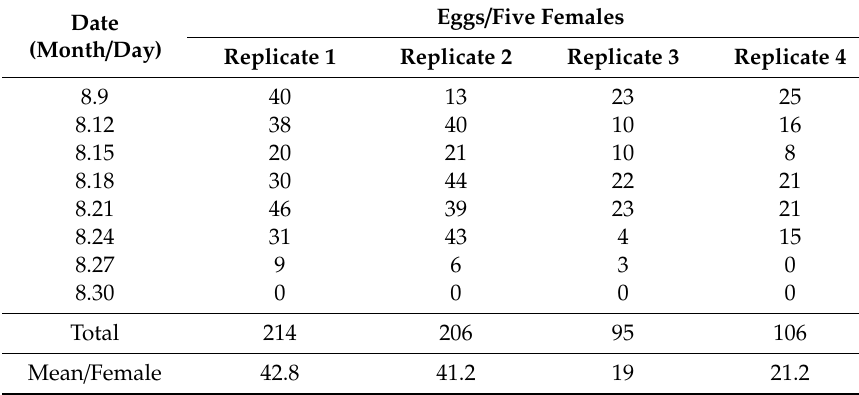
Table 7. Total number of eggs laid by a single female of E.